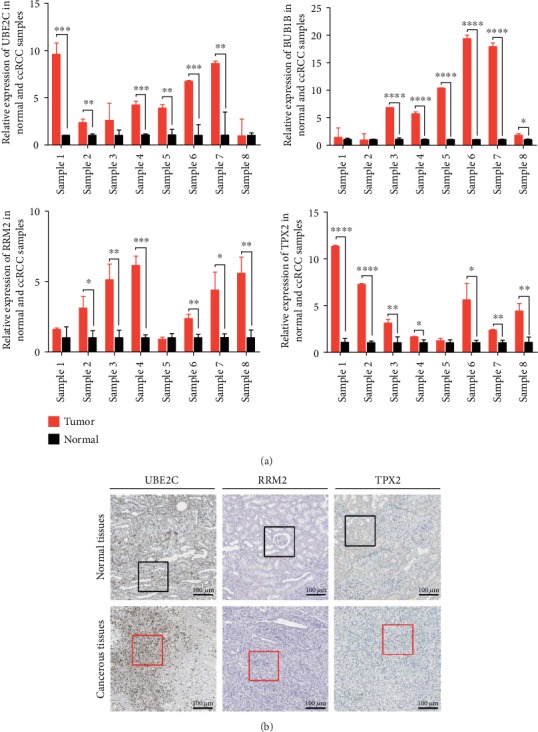
Validation of RNA and protein expression levels for hub genes. (a) Experimental validation of UBE2C, BUB1B, RRM2, and TPX2 in 8 paired clinical ccRCC samples. Data are presented as the means ± SEM. ∗P < 0.05, ∗∗P < 0.01, ∗∗∗P < 0.001, and ∗∗∗∗P < 0.0001. (b) UBE2C, RRM2, and TPX2 protein expression levels in ccRCC as compared to those in normal kidney tissues by IHC staining. Scale bars represent 100 μm. Black and red square boxes represent typical normal kidney and ccRCC tissues, respectively.